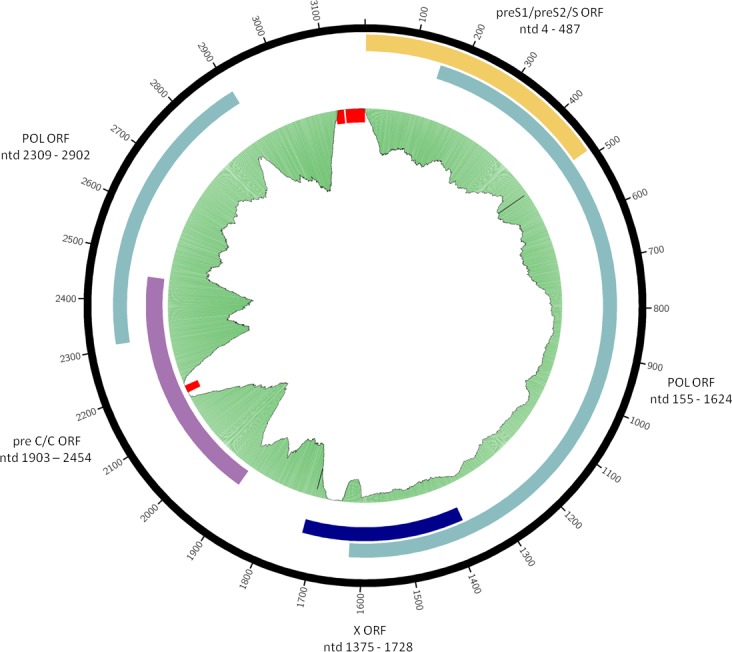
Consensus sequence of the Karsdorf HBV genome.Organization of overlapping open reading frames and approximate location of single-stranded portion of plus strand are indicated. Gaps in the sequence are marked in red. The green plot depicts the coverage of the re-mapping of raw reads against the consensus. Circular plots were generated using circos-0.69-6 and coverage information from the re-mapping.